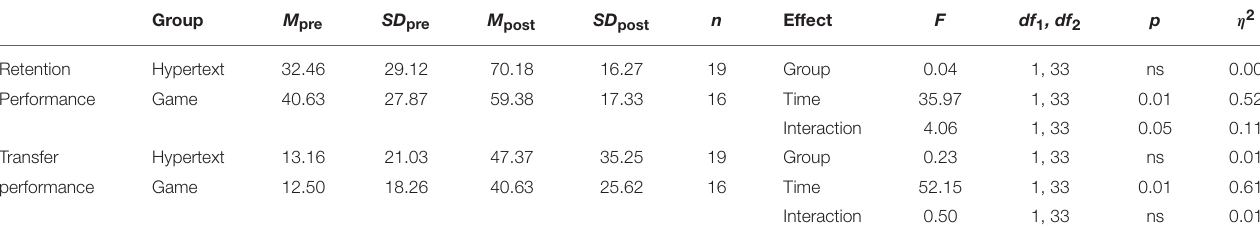
TABLE 8 | Descriptive statistics and the test results of the retention and transfer performance analyses for learners who completed Level 4. Group M pre SD pre M